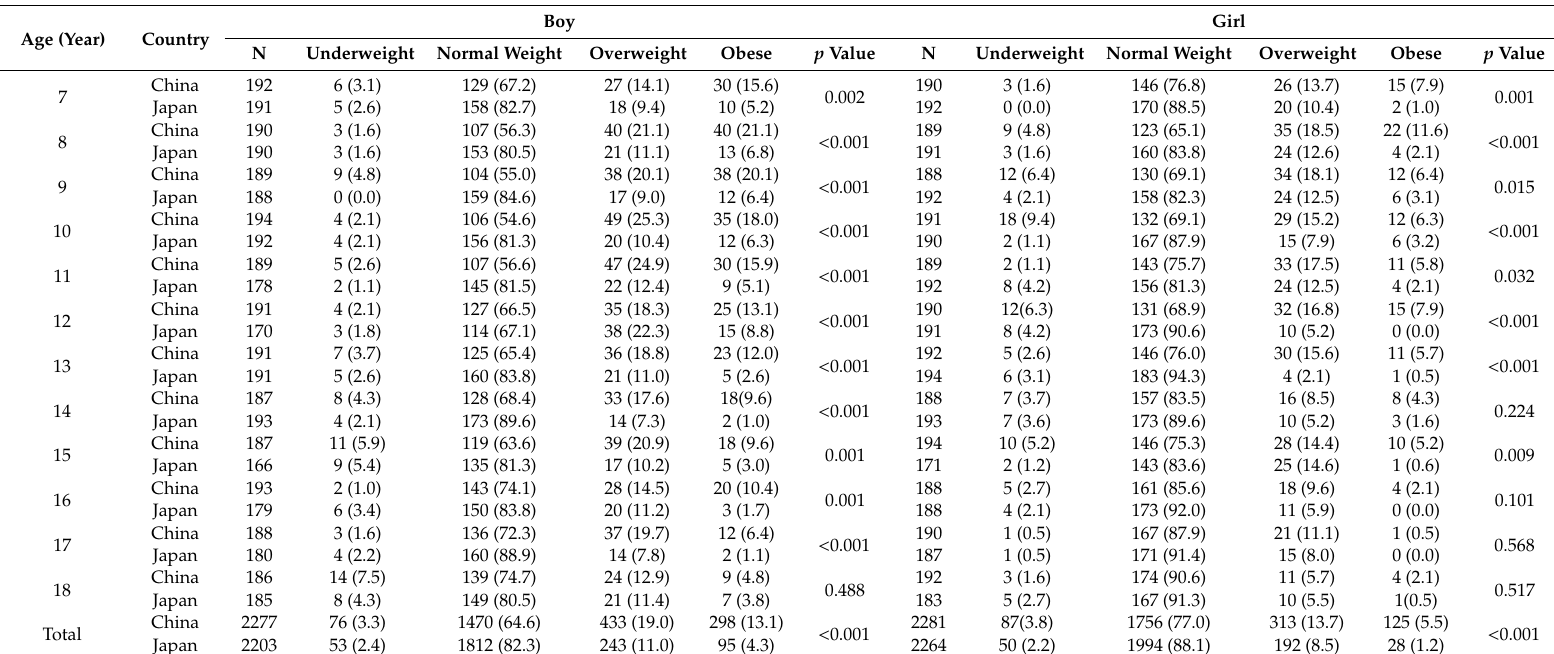
Table 6. Rate of underweight, overweight, and obesity between Chinese and Japanese children and adolescents (N